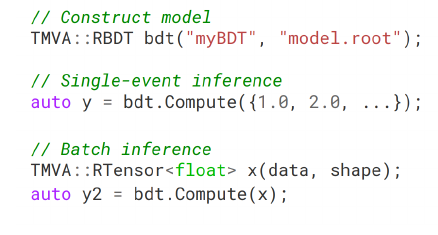
Figure 2. Example for the modernized TMVA interfaces in C ++